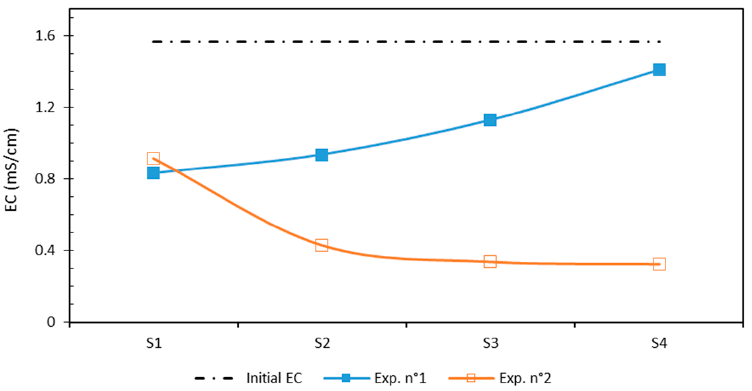
Figure 4. Distribution of EC after EKR test.